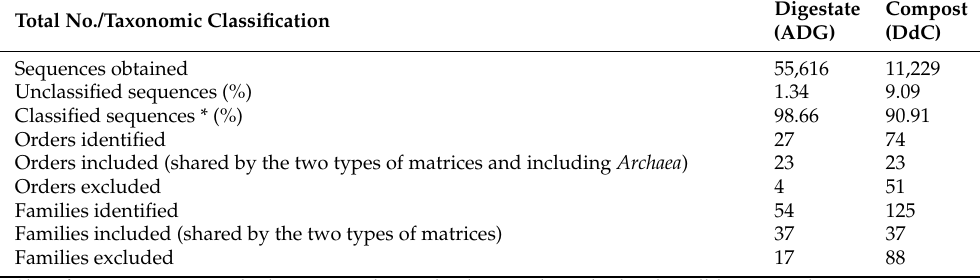
Table 1. Overview of metagenomic results based on 16S rRNA gene amplicons high-throughput sequencing of digestate and stabilized digestate-derived compost samples from agro-waste.